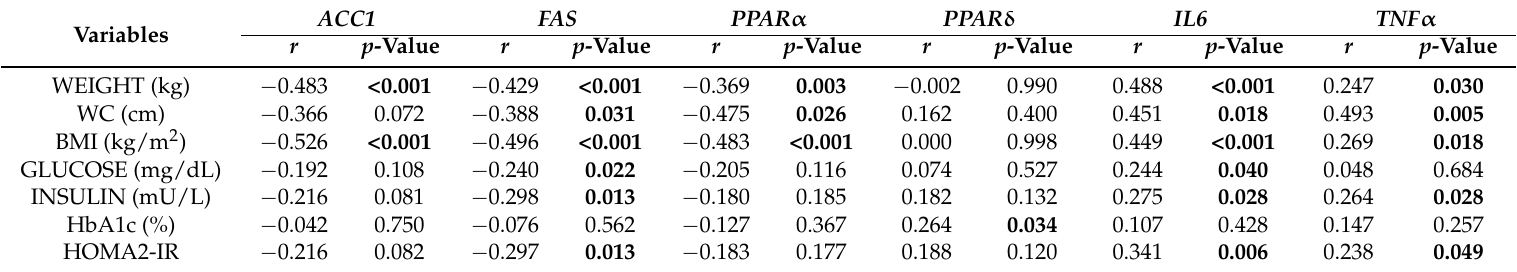
Table 3. Correlations of subcutaneous mRNA expression of genes involved in fatty acid metabolism and inflammation with anthropometric and glucose metabolism